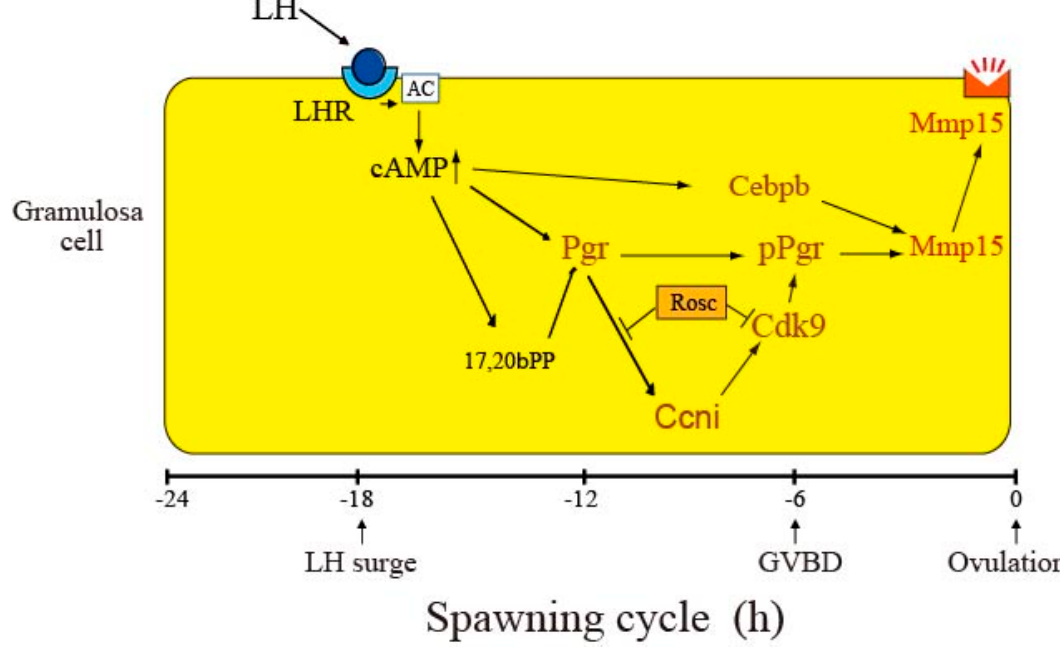
Figure 8. A model for the roles of Ccni and Cdk9 in the process of LH-induced expression of Mmp15 in medaka ovulation. For details, see the text. Note that transcription of pgr , cebpb , ccni , cdk9 , and mmp15 gene occurs in the nucleus of the granulosa cell.